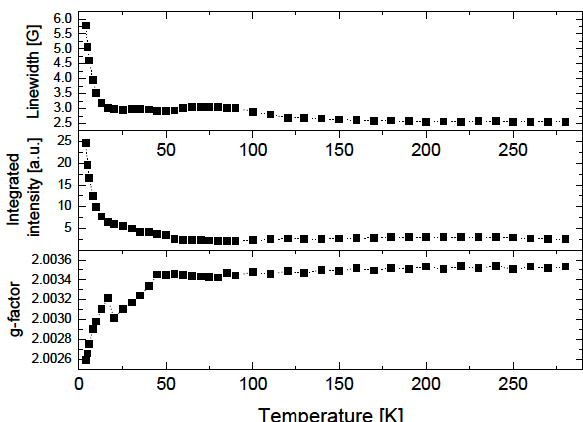
Figure 7: EPR spectra at RT of the N component in the studied sam- ples. Due to very strong EPR signals the samples B-800 and B-850 are presented separately in insert with greatly enlarged vertical scale.